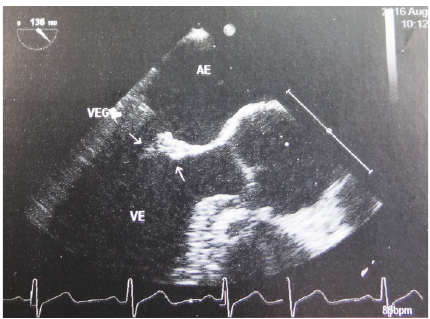
Figure 1: Vegetation on the anterior leaflet of the mitral valve shown on transesophageal